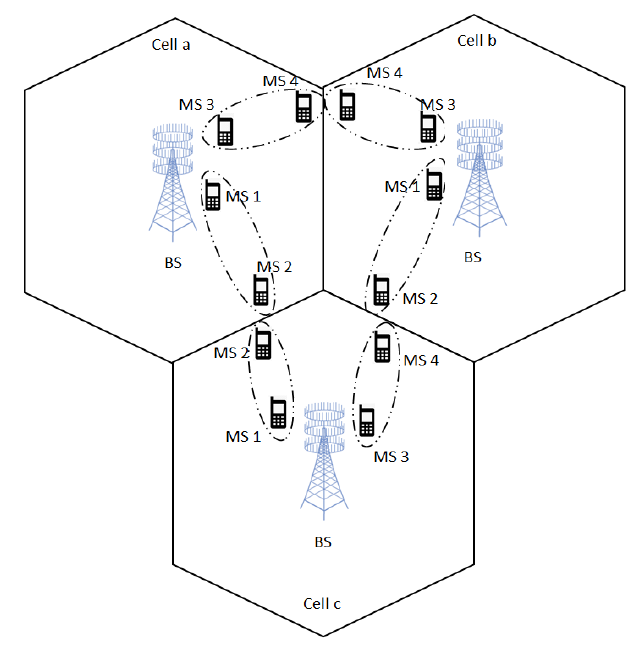
Figure 1. Multicell Massive multiple-input multiple-output non-orthogonal multiple access (MIMO-NOMA) downlink